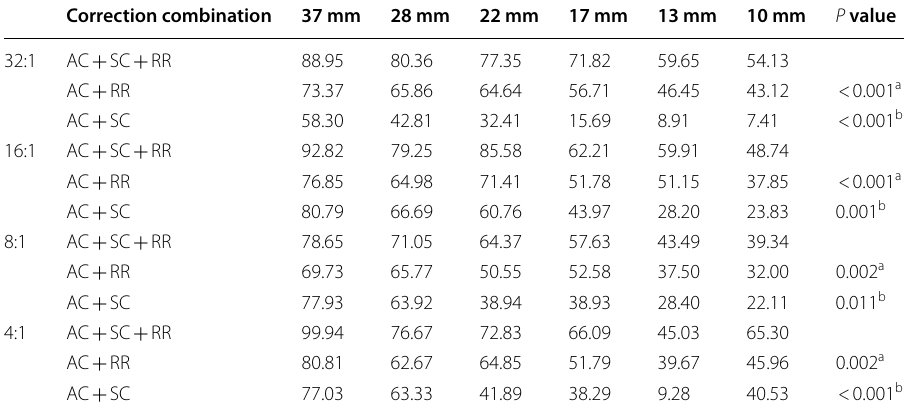
Table 3 Comparison of per cent contrasts (%) of all spheres among three different correction combinations